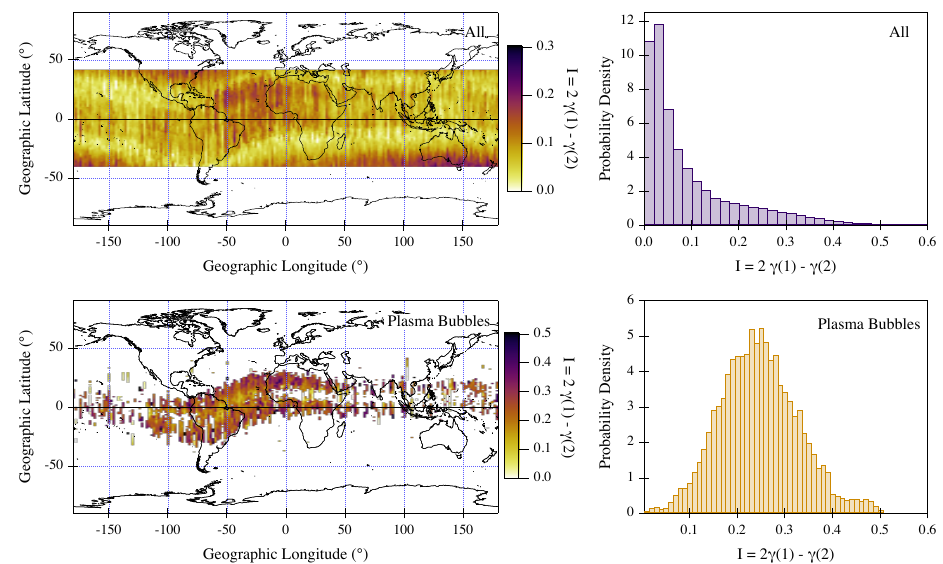
Figure 3. ( Top ): Intermittency values for electron density data selected under the following condi- tions: 18:00–24:00 LT, ± 40 ◦ geographic latitude, and Kp ≤ 3 in the latitude–longitude plane ( left ) and corresponding probability density ( right ). ( Bottom ): Intermittency values for electron density data associated with plasma bubbles in the latitude–longitude plane ( left ) and corresponding probability density ( right